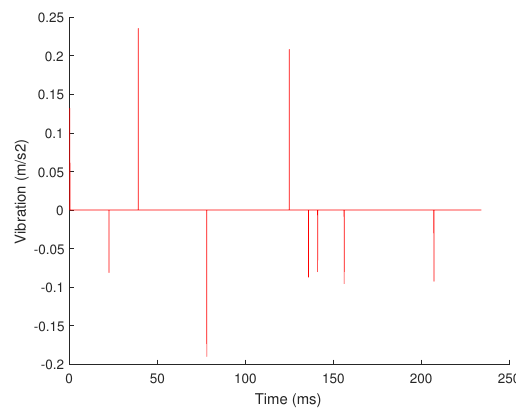
Figure 11. 5th-level decomposition signal.